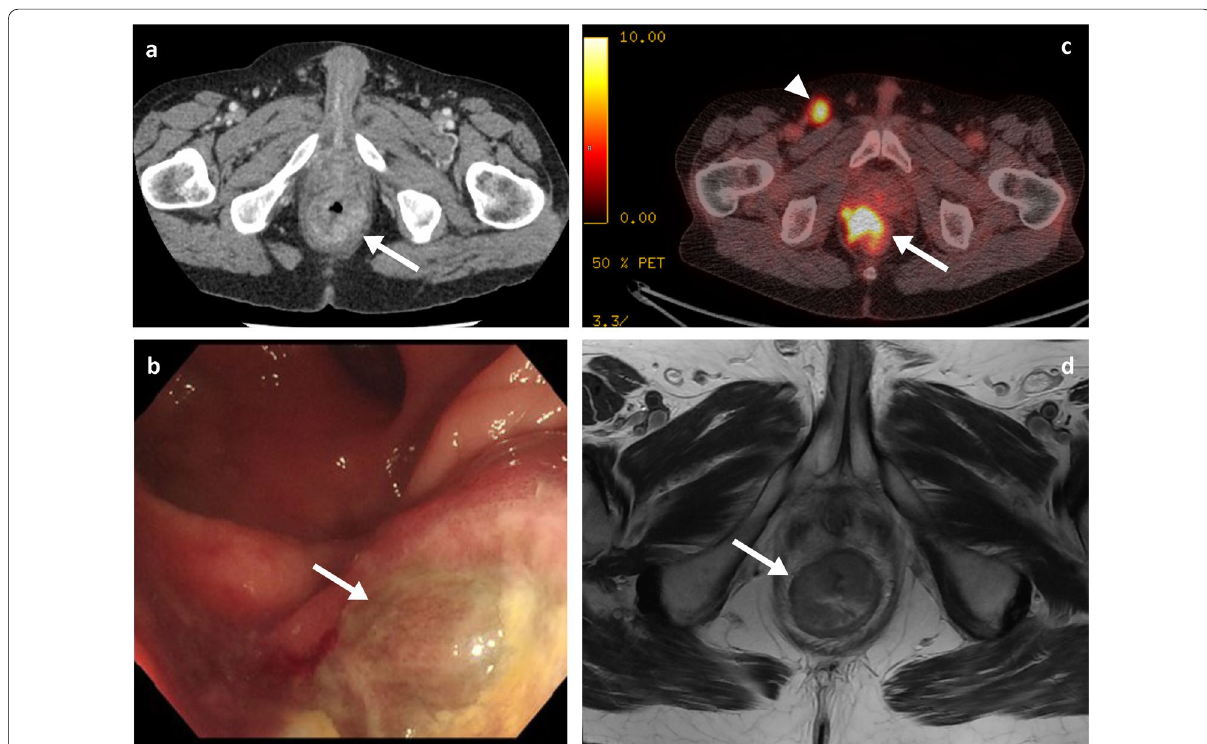
Fig. 11 Portal phase contrast-enhanced CT axial ( a ), colonoscopy ( b ), PET-CT axial ( c ) and MRI T2WI axial ( d ) of a 64-year-old male patient with an infiltrative metastatic anorectal melanoma mass. The PET-CT ( c ) also demonstrates a pathological right inguinal node